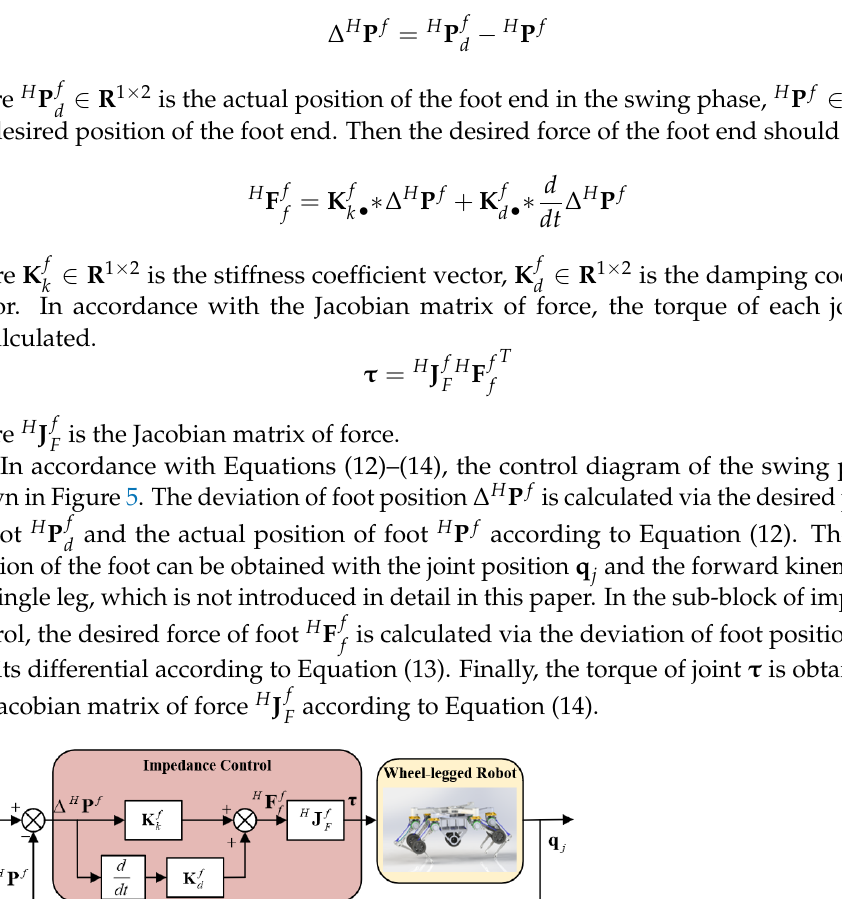
7 of 20 Figure 4. Control block diagram of the stance phase. The control block diagram has two main sub- blocks: sub-block of velocity planning and sub-block of impedance control. The sub-block of veloc- ity planning plans the desired velocity of the torso and the desired velocity of the foot. The sub- block of impedance control calculates the torque of joints to control the wheel-legged robot to exe- cute the desired motion. 3.1.2. Swing Phase